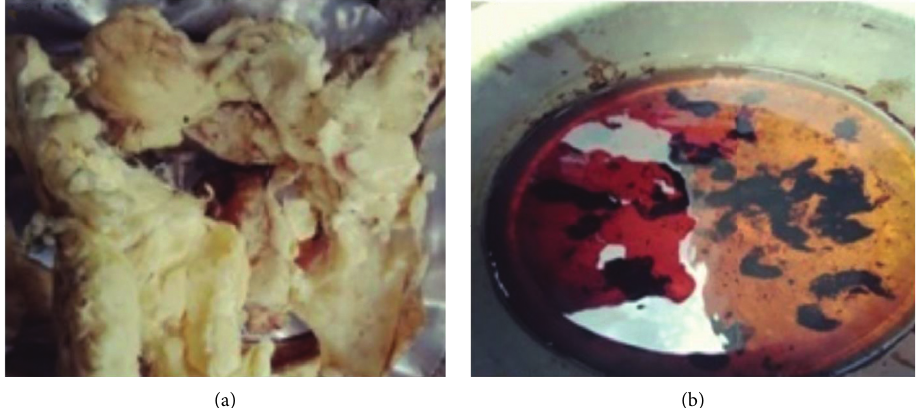
Figure 2: (a) Dry animal fat collected; (b) fat oil generated from WAF.